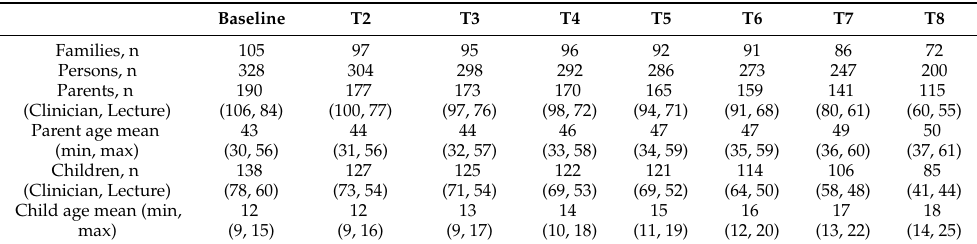
Table 1. Total enrollment and demographics by assessment